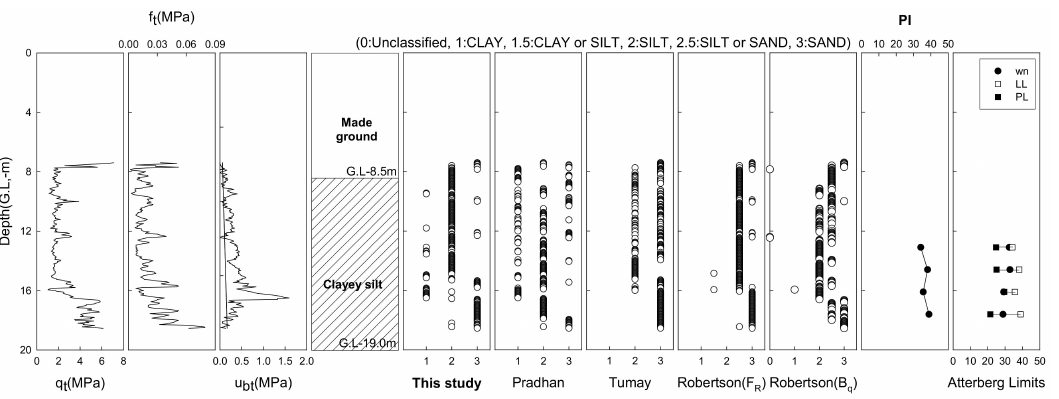
Figure 14. Verification results at Incheon trade center site.